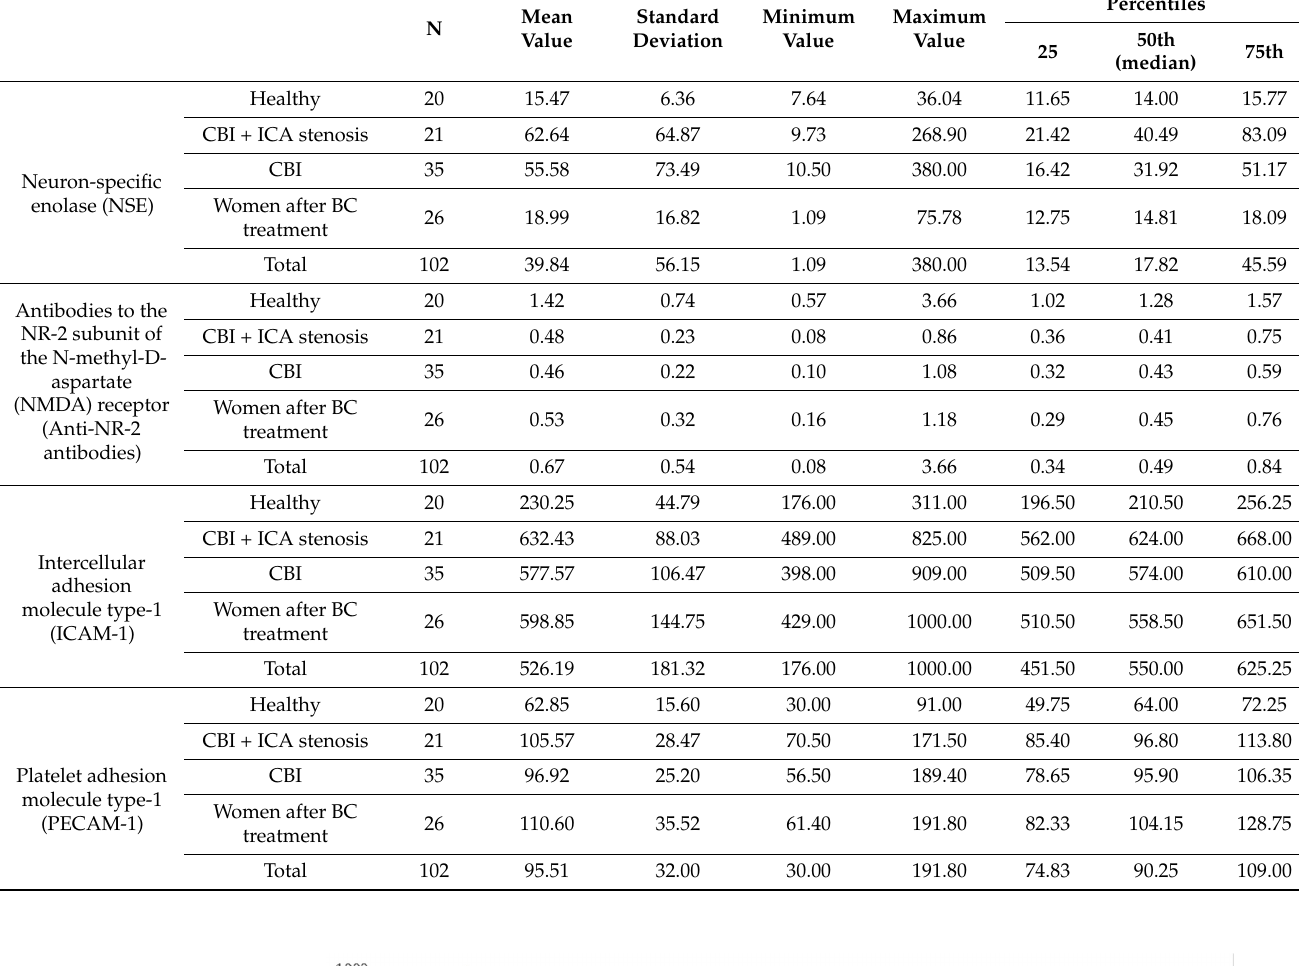
Table 4. Serum biomarker levels in the study groups (n = 102).